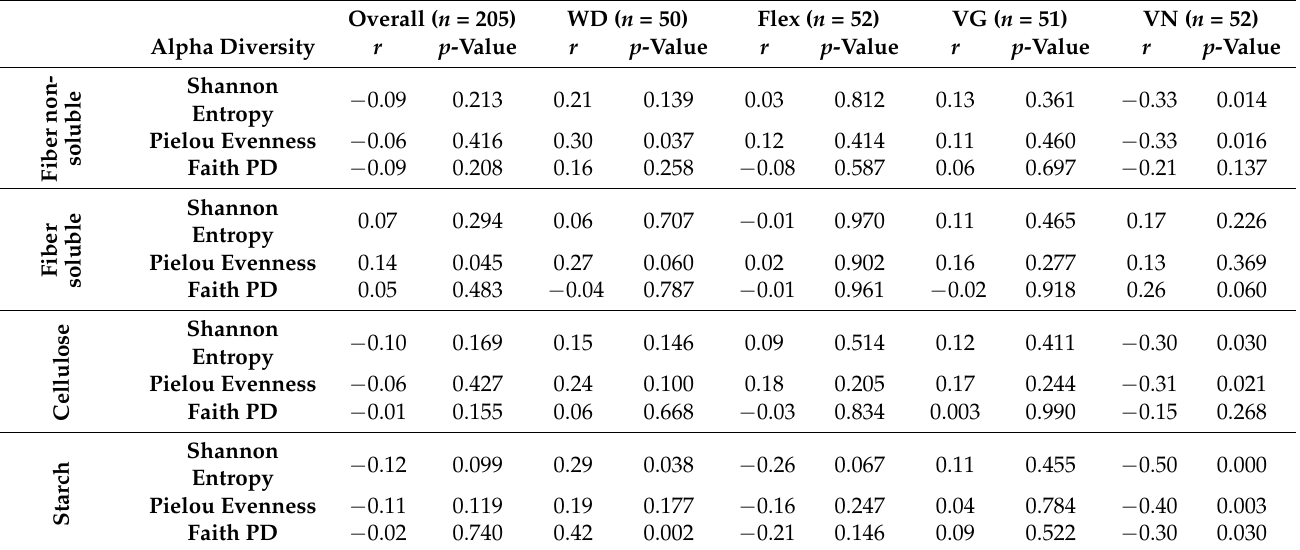
Table 9. Pearson correlation between fiber compounds (g/day) and alpha diversity in diet